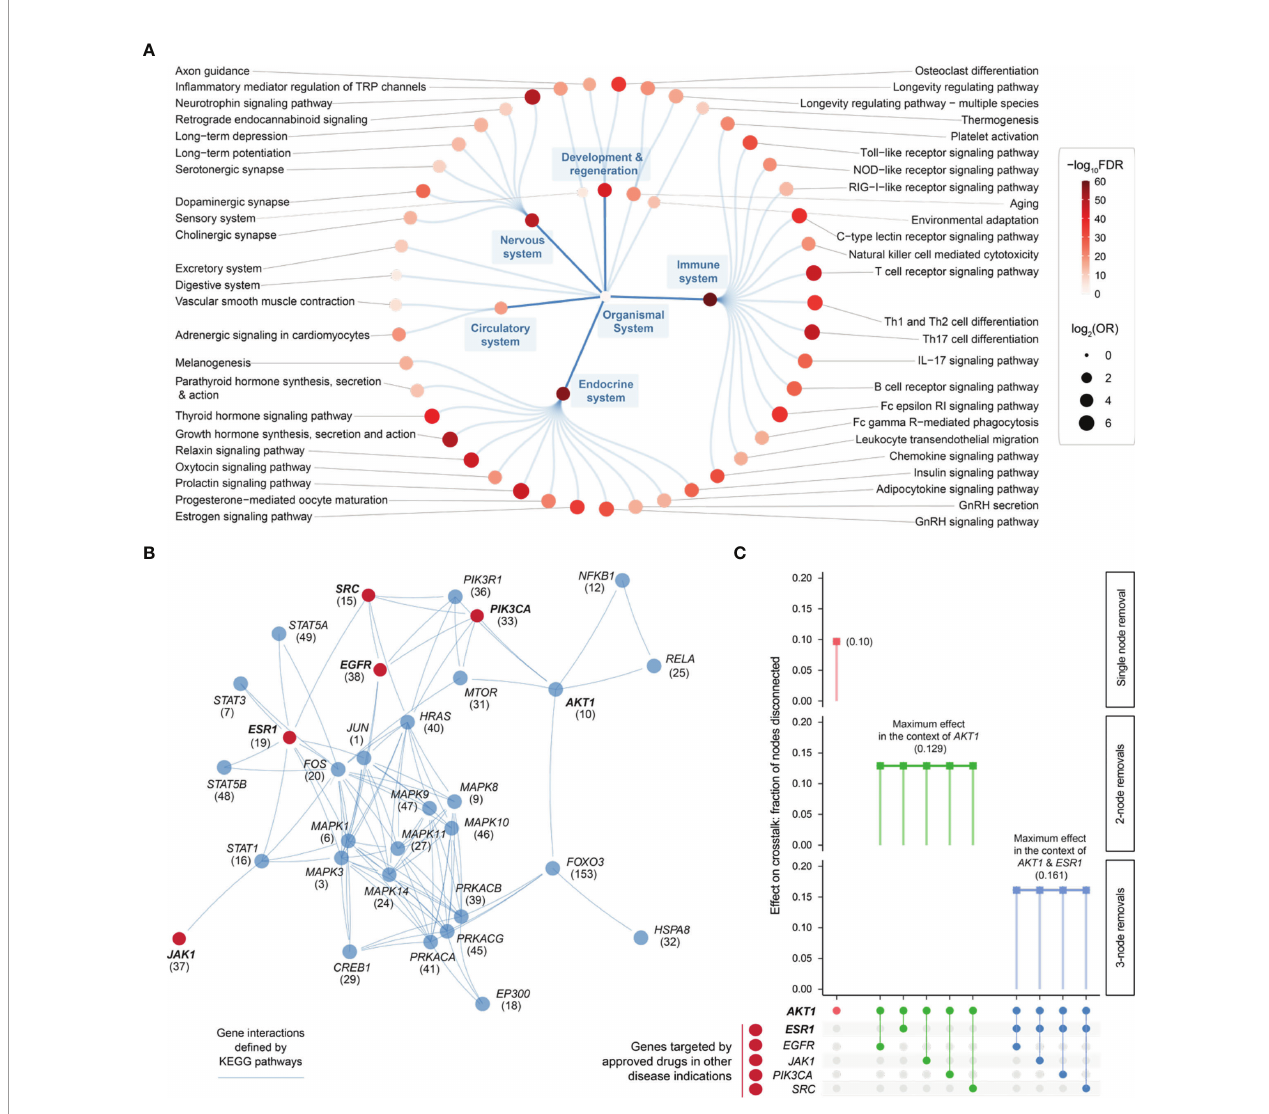
FIGURE 6 | Pathway crosstalk-based attack analysis identi fi es critical genes and repurposes licensed medications. (A) Pathway enrichments of the top 1% prioritized target genes. Based on KEGG organismal system pathways that are organized circularly. Each dot represents a pathway, sized by the odd ratio (OR) and colored by the signi fi cance level (FDR) calculated using one-sided Fisher ’ s exact test. (B) Pathway crosstalk identi fi ed by integrating target prioritization information with gene interactions (extracted from enriched pathways). Nodes are labelled by gene symbols (priority rank) and highlighted in red if currently targeted by approved drugs in other disease indications. (C) Effect of node removals on the crosstalk. Top: the single-node effect maximized by removing ATK1 , the maximum effect of removing another approved drug target in the context of AKT1 , and the maximum effect of removing another approved drug target in the context of AKT1 and ESR1 . Bottom: node removals are indicated by colored